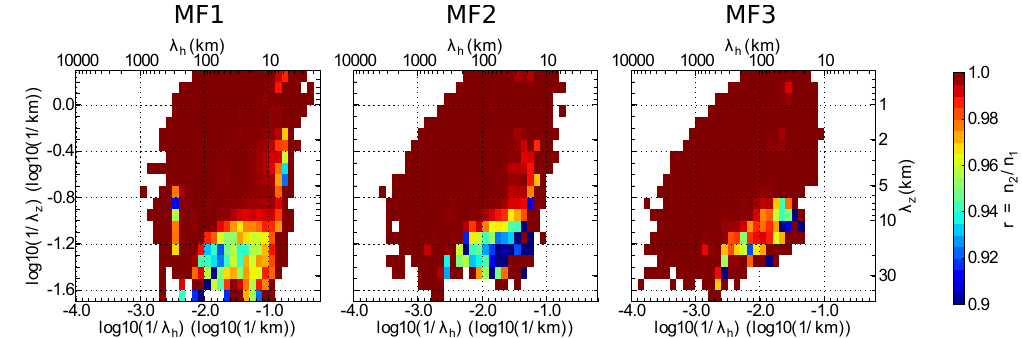
Figure 14. Variation of the number-of-wave-event spectrum after considering the difference between the observed vertical wavelengths for upward and downward scans. The variation is shown here for MF1 (left column), MF2 (middle column) and MF3 (right column) with the observation geometry of HIRDLS. For details, see